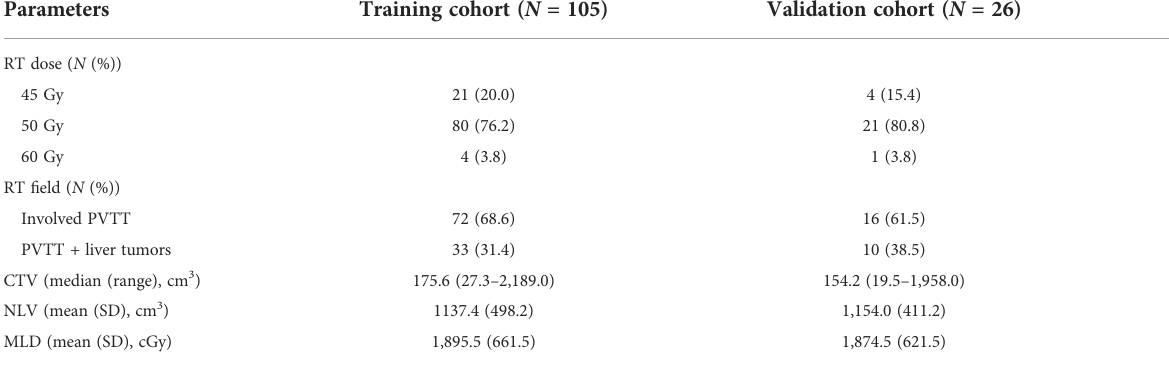
TABLE 4 RT dosimetric parameters of the training and validation cohorts.